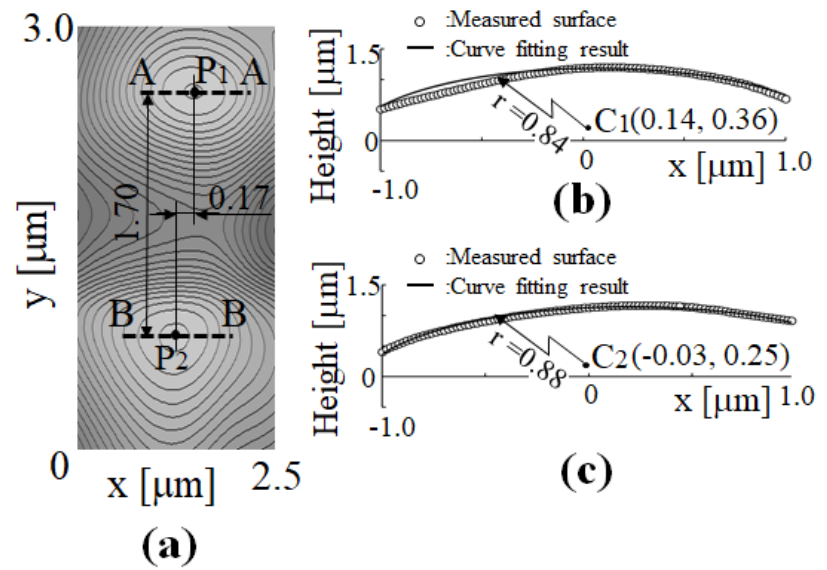
Figure 7. Measured results: ( a ) Contour of 3D shape; ( b ) Measured shape of section A-A; ( c ) Measured shape of section